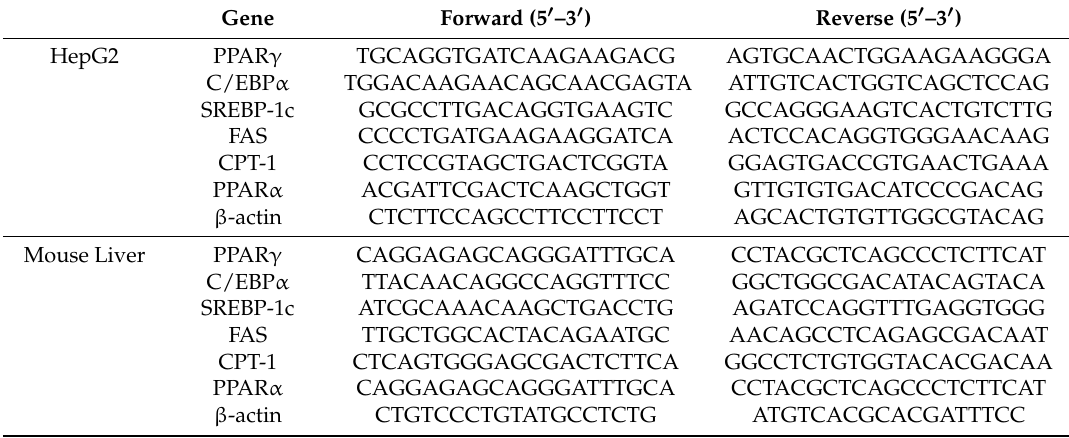
Table 1. Primer sequence used for real-time quantitative